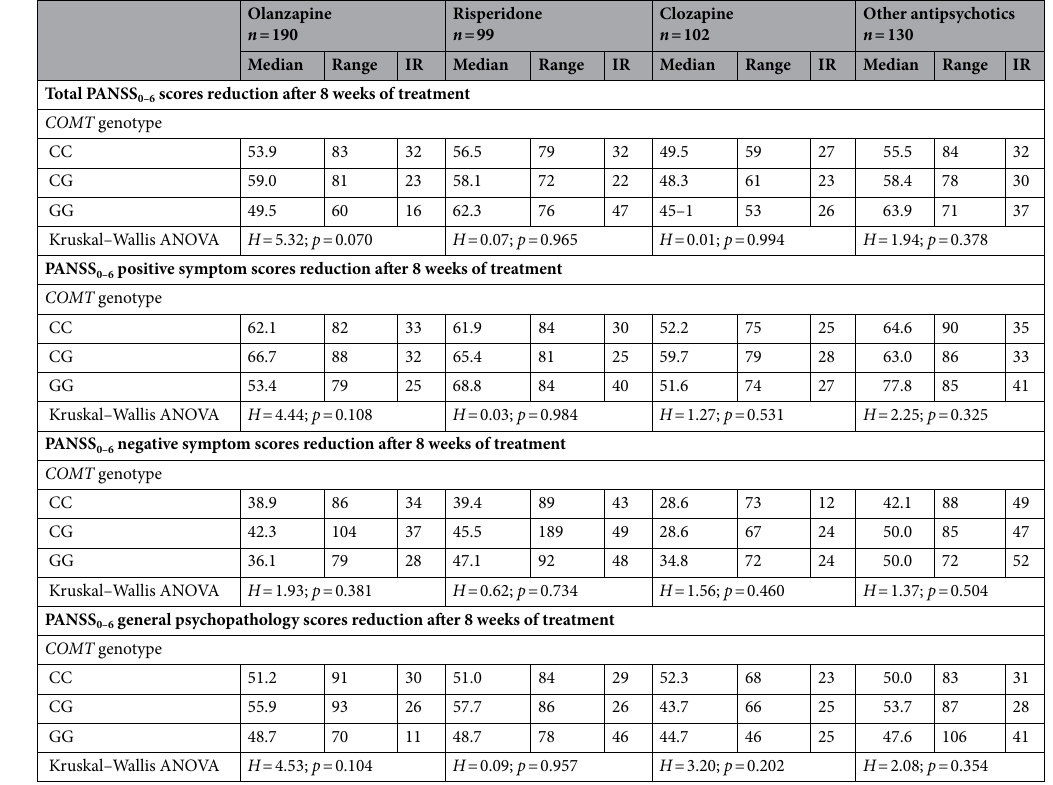
Table 6. Percentage reduction from the initial PANSS 0–6 total and subscale scores after 8 weeks of treatment with olanzapine, risperidone, clozapine or other antipsychotics in schizophrenic patients subdivided according to the COMT rs4818 genotypes. Values are given as median, range and interquartile range (IR) n number of subjects, PANSS positive and negative syndrome scale.